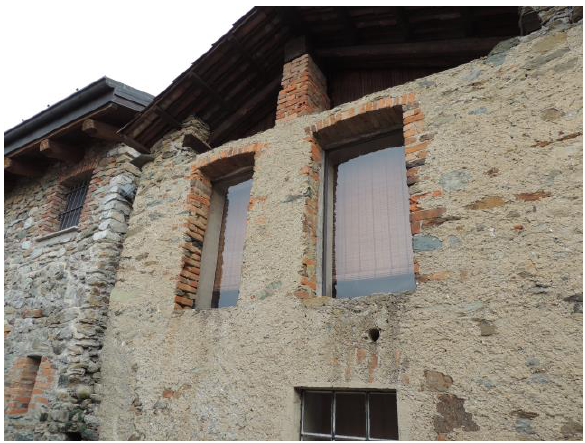
Figure 16. Building F - Intervention preserving both the external masonry surfaces and the roof (credits Silvia Rescic).